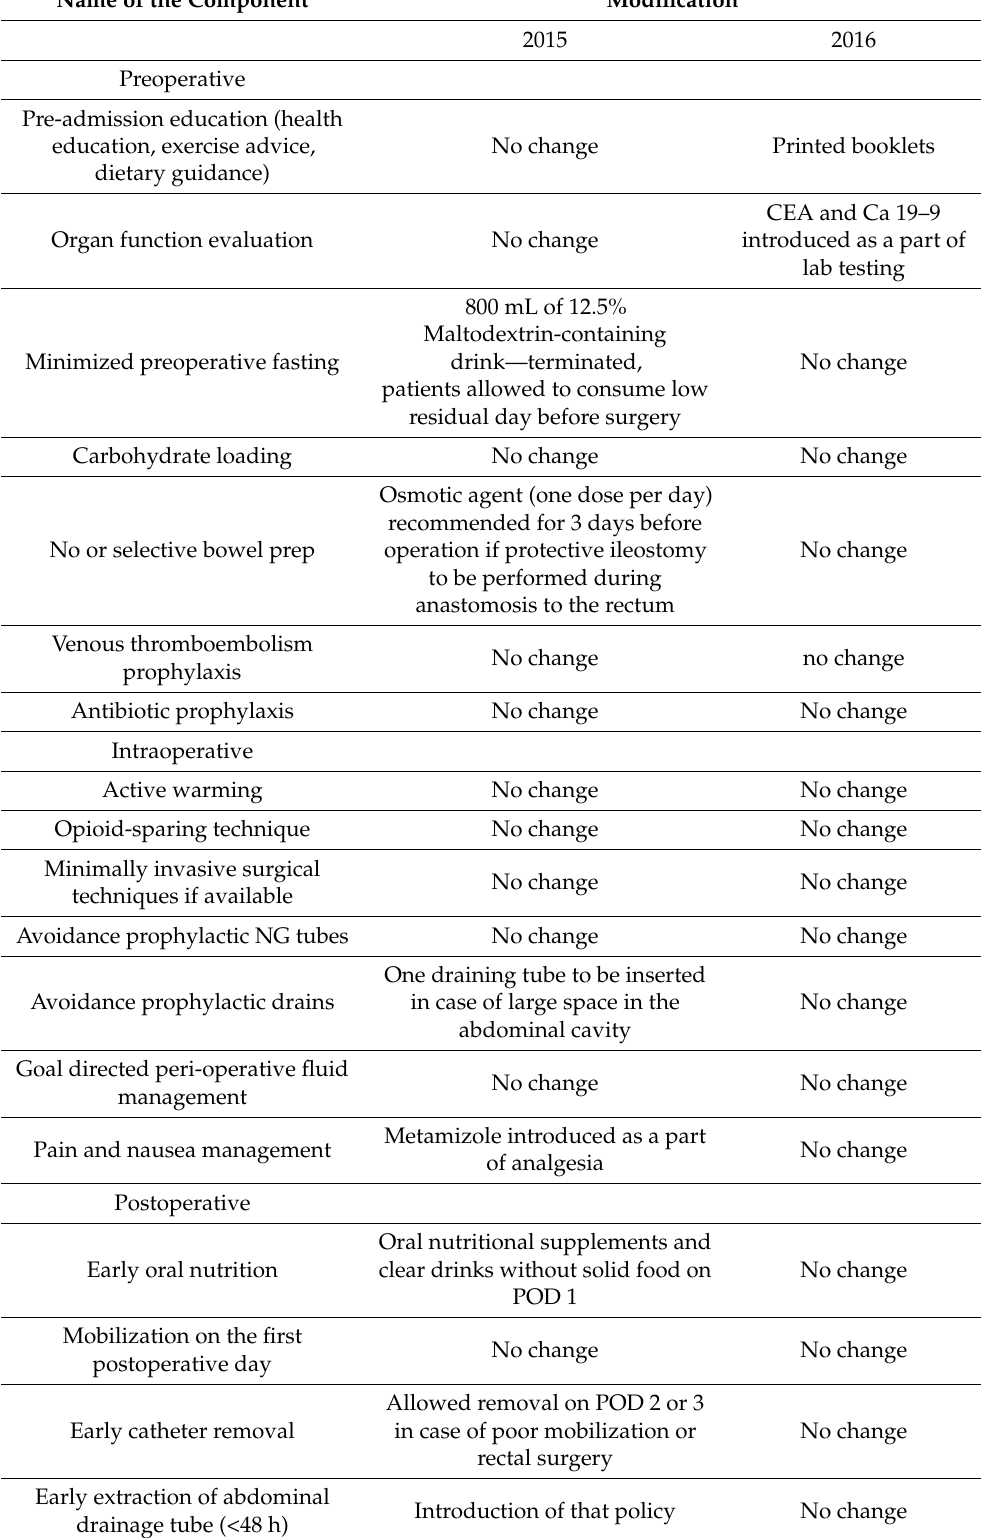
Table 3. Modifications to the